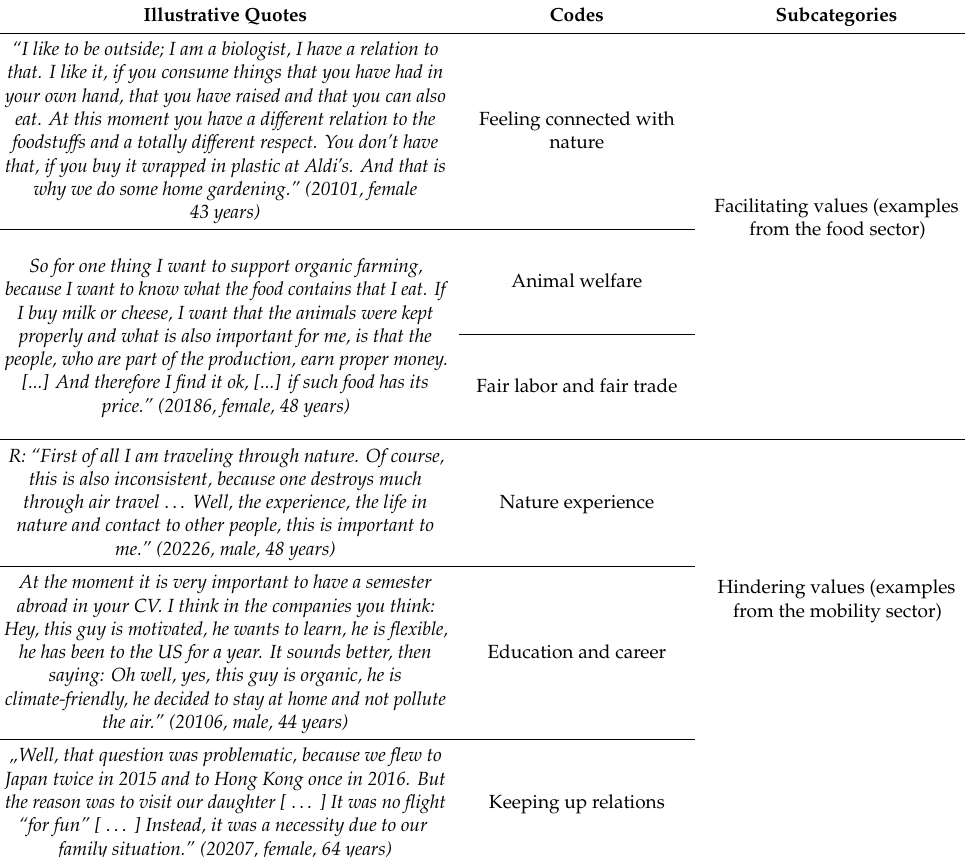
Table 6. Illustrative quotes of some hindering or facilitating values in the food and mobility